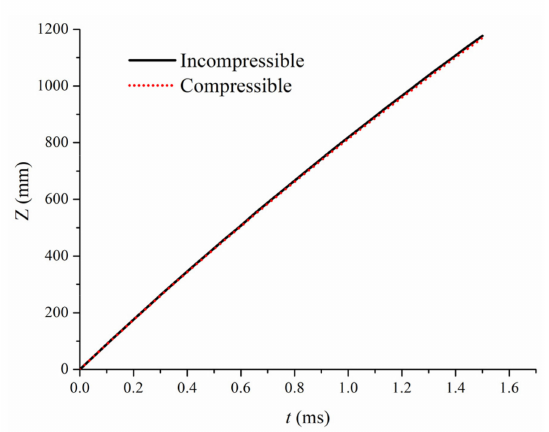
Figure 10. Velocity attenuation of incompressible and compressible liquid.